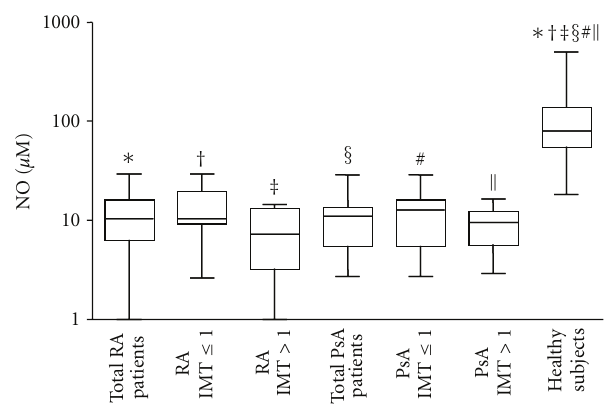
Figure 2: Nitric oxide (NO) concentrations in serum samples . Box plot graphs showing NO concentrations in serum samples from the 24 patients with rheumatoid arthritis (RA) and 25 with psoriatic arthritis (PsA), divided or not according to IMT values obtained by Echo-colour Doppler images and from the 13 healthy subjects. ∗ ‡ § # (cid:6) P < 0 . 0001; † P = 0 . 0008.